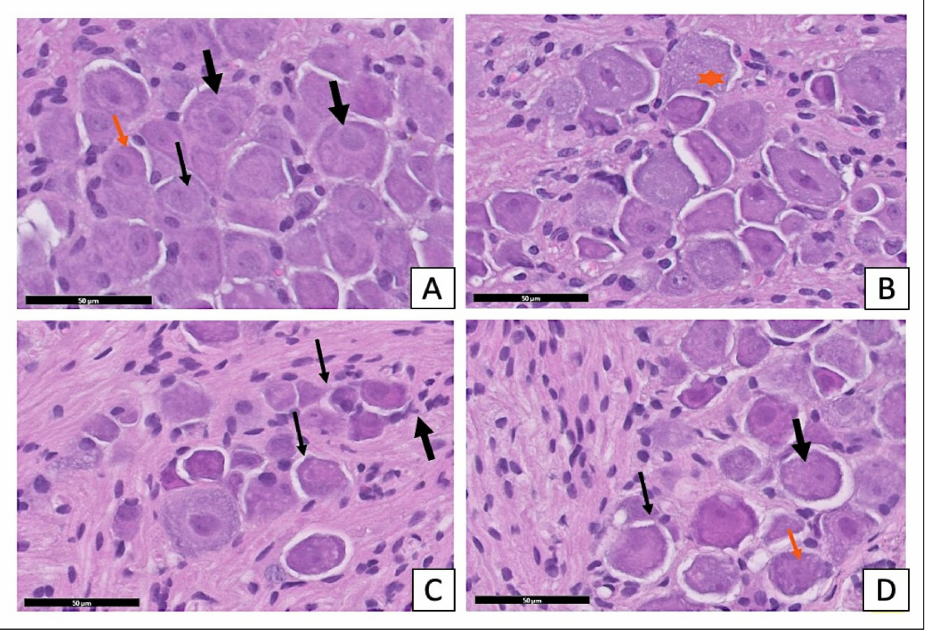
Figure 4. Effect of X. testudinaria extract on histopathological changes of DRG in streptozotocin (STZ)-induced diabetes in mice using H and E: a photomicrograph of the dorsal root ganglia (DRG) of the control group ( A ), X. testudinaria extract-only group ( B ), STZ-diabetic group ( C ), and STZ-diabetic on X. testudinaria -treated group ( D ). Arrows show neurons and stars mark large-diameter nerve cells. Thick black arrows show satellite cells. H&E scale bar at 50 µ m was